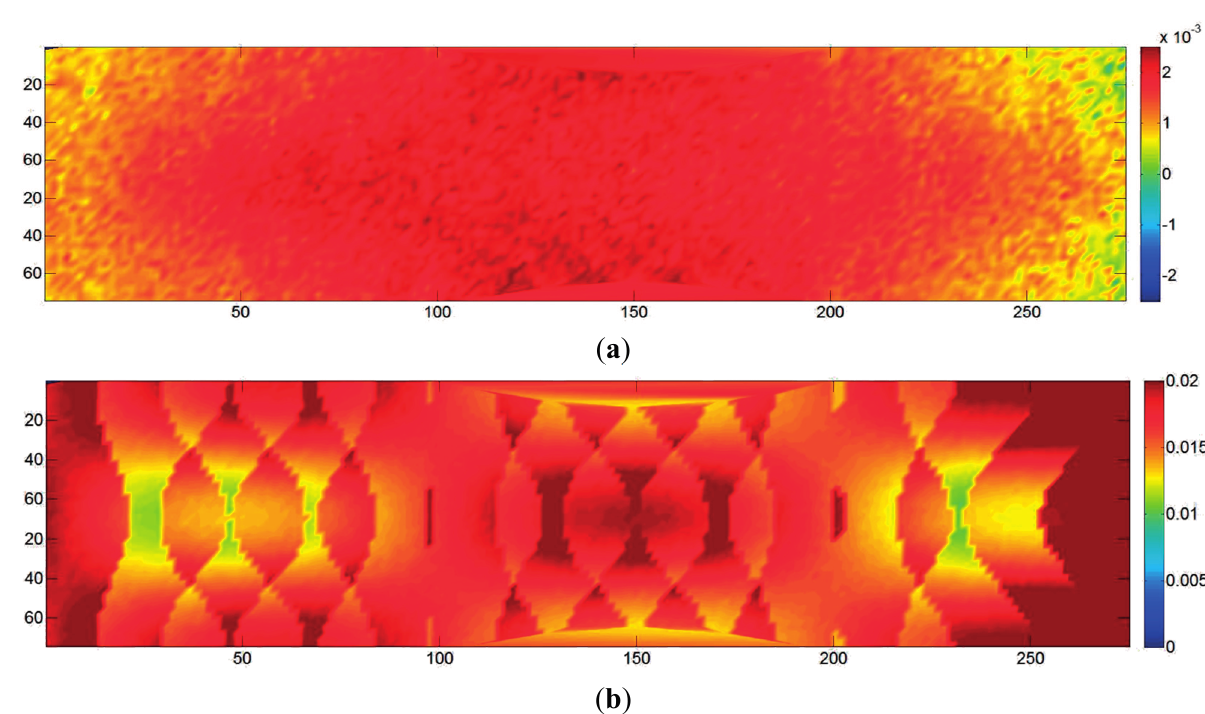
Figure 5. Case 1-A: single strip with four GCP (two on each end), 80% overlap, pre-calibrated. ( a ) Colour map of the mean error; ( b ) colour map of the standard deviation of the